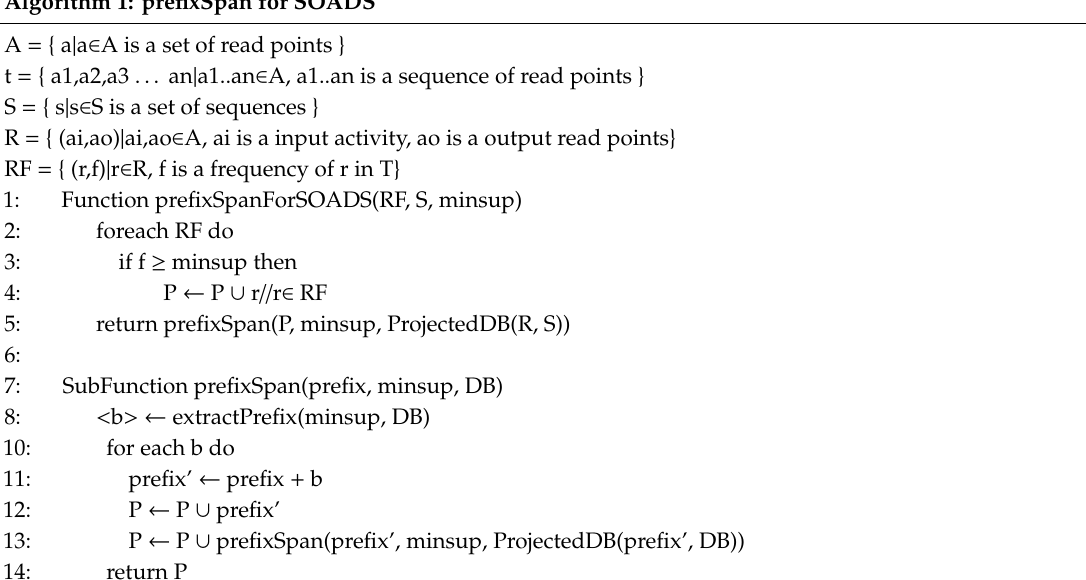
Algorithm 1: prefixSpan for